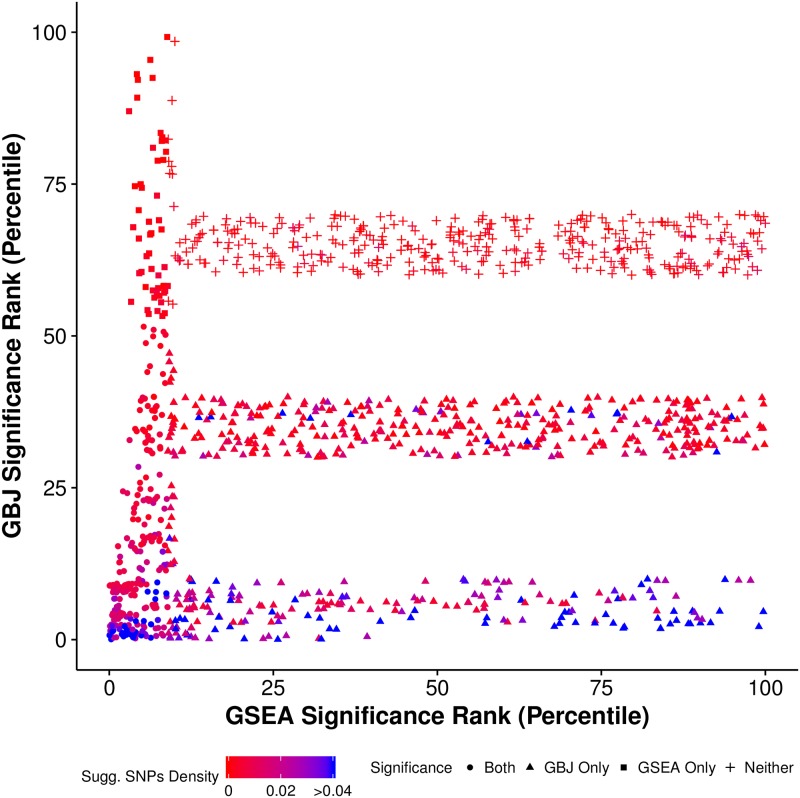
Significance rank of breast cancer pathways tested by both GBJ and GSEA.The significance ranking of pathways according to GBJ and GSEA, colored according to density of SNPs with p < 10−5. Pathways are ordered according to p-value (GBJ) or q-value (GSEA), smaller rankings indicate more significance. For the sake of presentation, we only show pathways in the top ten percentiles of either GSEA or GBJ as well as pathways in the 30th-40th and 60th-70th percentiles of GBJ. Pathways ranked by GBJ as more significant generally have a higher proportion of SNPs with p < 10−5. In contrast, there is no discernible relationship between a pathway’s GSEA ranking and its density of suggestive signals.